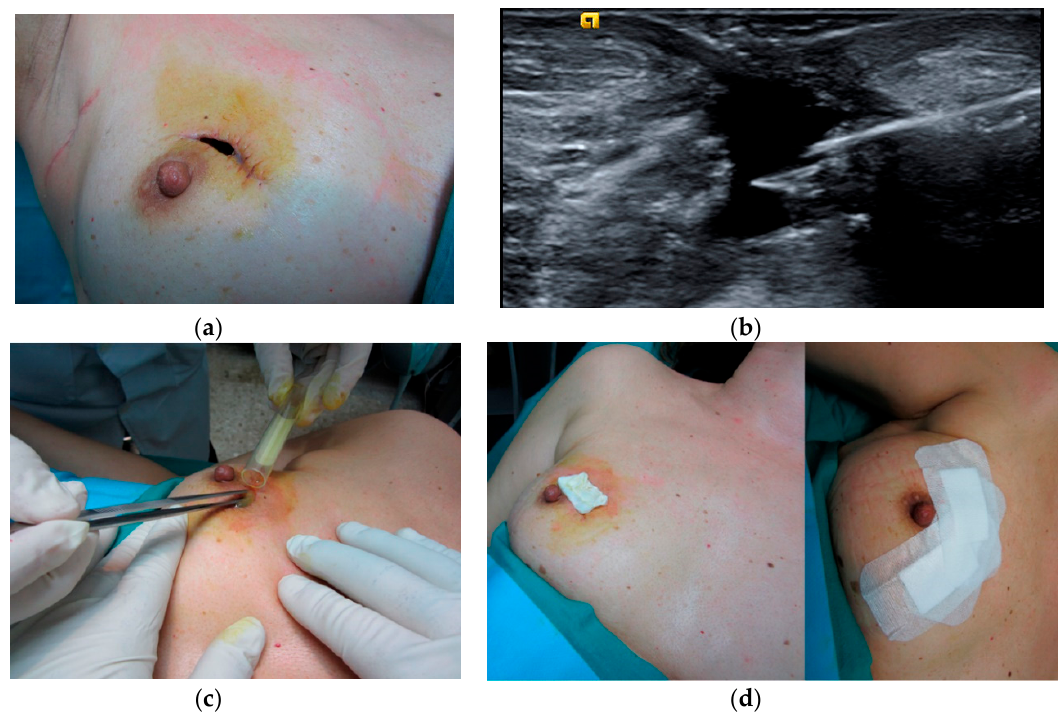
Figure 1. Application of platelet-rich plasma (PRP) in a case of wound dehiscence. ( a ) Pretreatment, ( b ) ultrasound image showing injection of PRP in the wound cavity, ( c ) PRP gel applied to the wound, ( d ) the wound was covered with a collagen dressing and adhesive dressings.